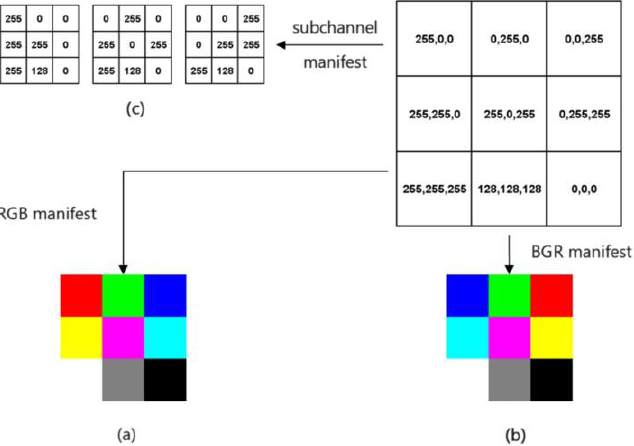
Figure 2. Schematic diagram of the whitening process of ECG signal: ( a , b ) Red, green and blue (RGB) three-channel diagram; ( c ) Sub-channel representation results.